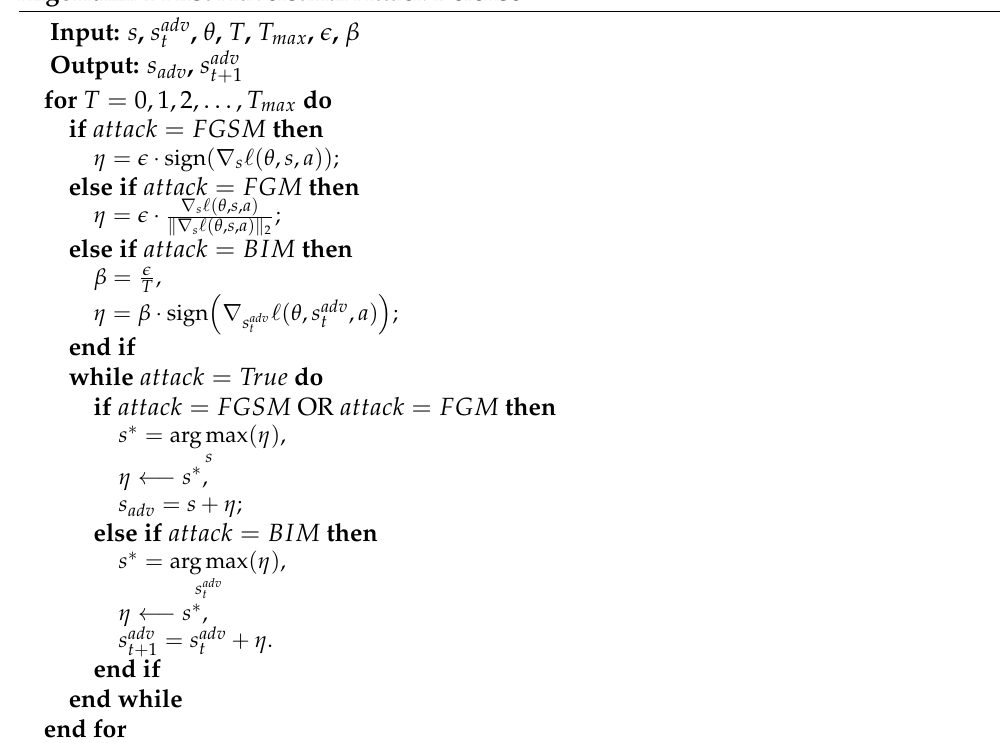
Algorithm 1 First Adversarial Attack